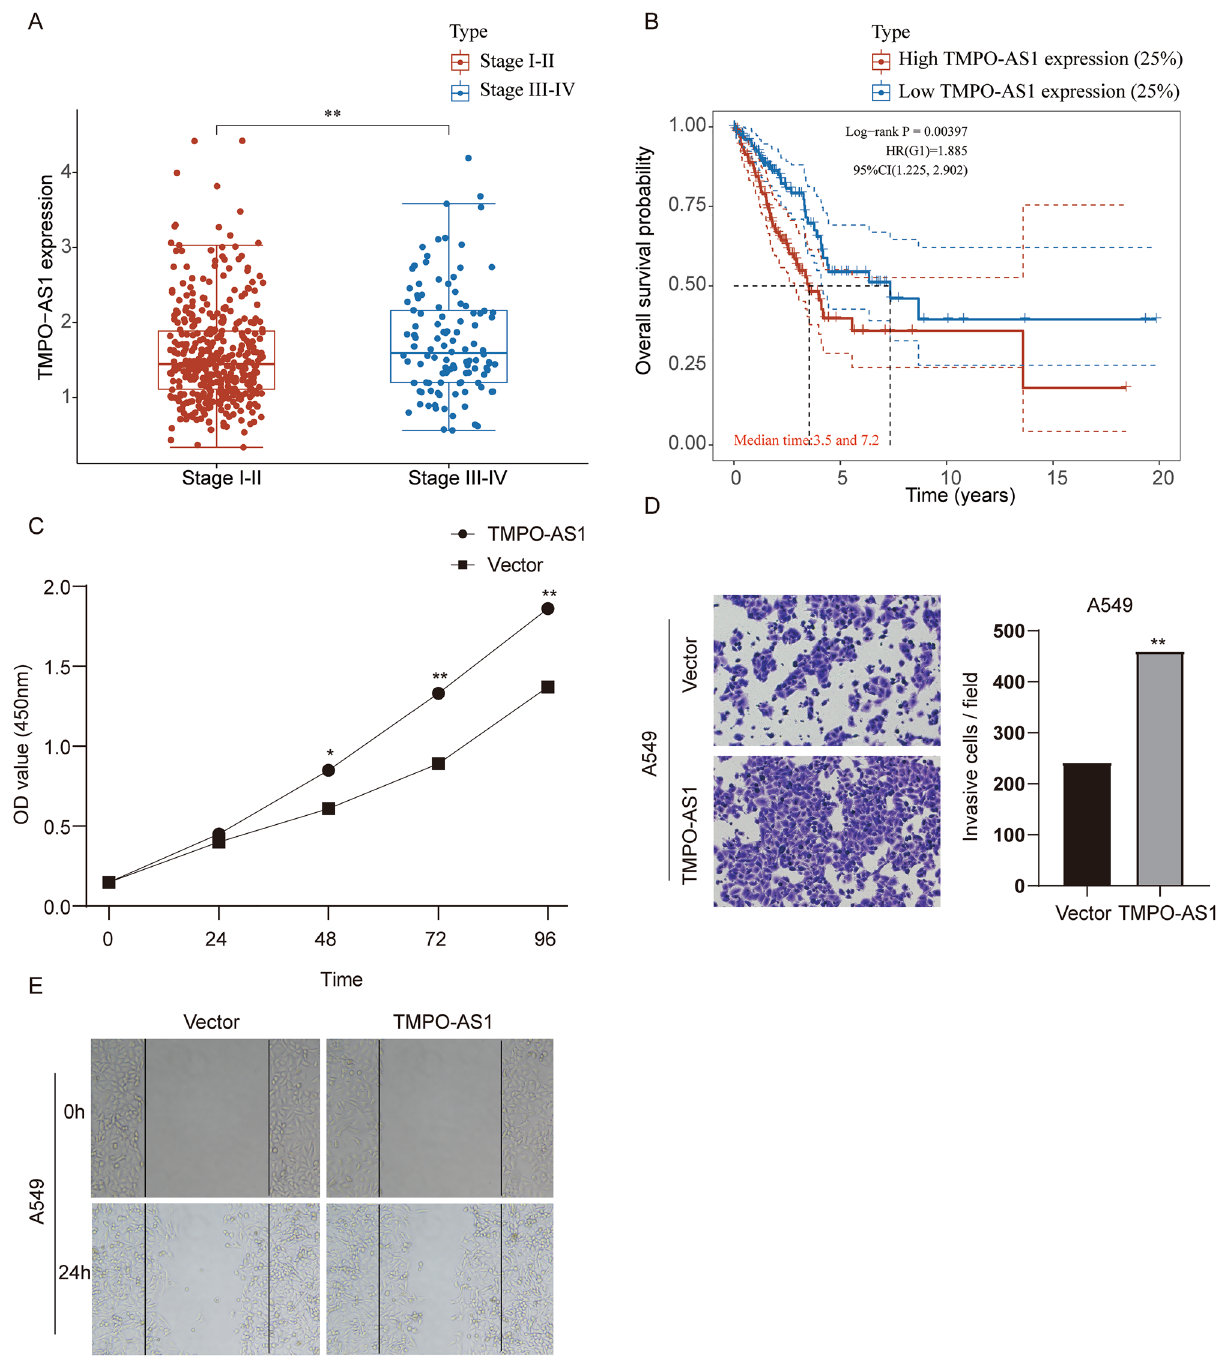
Figure 8. The effect of TMPO-AS1 overexpression on A549 cell proliferation, migration and invasion. ( A ) Relative TMPO-AS1 expression of Stage III-IV LUAD patients compared with Stage I-II LUAD patients analyzed with the TCGA database. ( B ) Association of TMPO-AS1 expression with overall survival of LUAD patients. ( C ) The effect of TMPO-AS1 overexpression on the viability of A549 cell line. (D&E) The effect of TMPO-AS1 overexpression on the migration and invasion of A549 cell line. * p < 0.05, ** p < 0.01. Experiments were repeated three